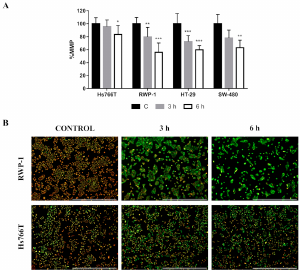
Figure 5. Role of MMP in resistance to CLytA-DAAO-induced cell death. ( A ) Hs766T, RWP-1, HT-29 and SW-480 cell lines were treated with CLytA-DAAO and D-Ala for 3 or 6 h and the MMP was determined using MitoTracker Green FM (all mitochondria staining) and MitoTracker Red CMXRos (polarized mitochondria staining) fluorescent dyes. Data represent the percentage of MMP, normalizing the control cells (C) as 100% ± SD with n ≥ 6. * indicates a p -value < 0.05, ** p -value < 0.01 and *** p -value < 0.001. ( B ) Representative fluorescent images of RWP-1 and Hs766T cell lines treated with CLytA-DAAO and D-Ala for 0, 3 or 6 h are shown. Scale bars, 1000 µ